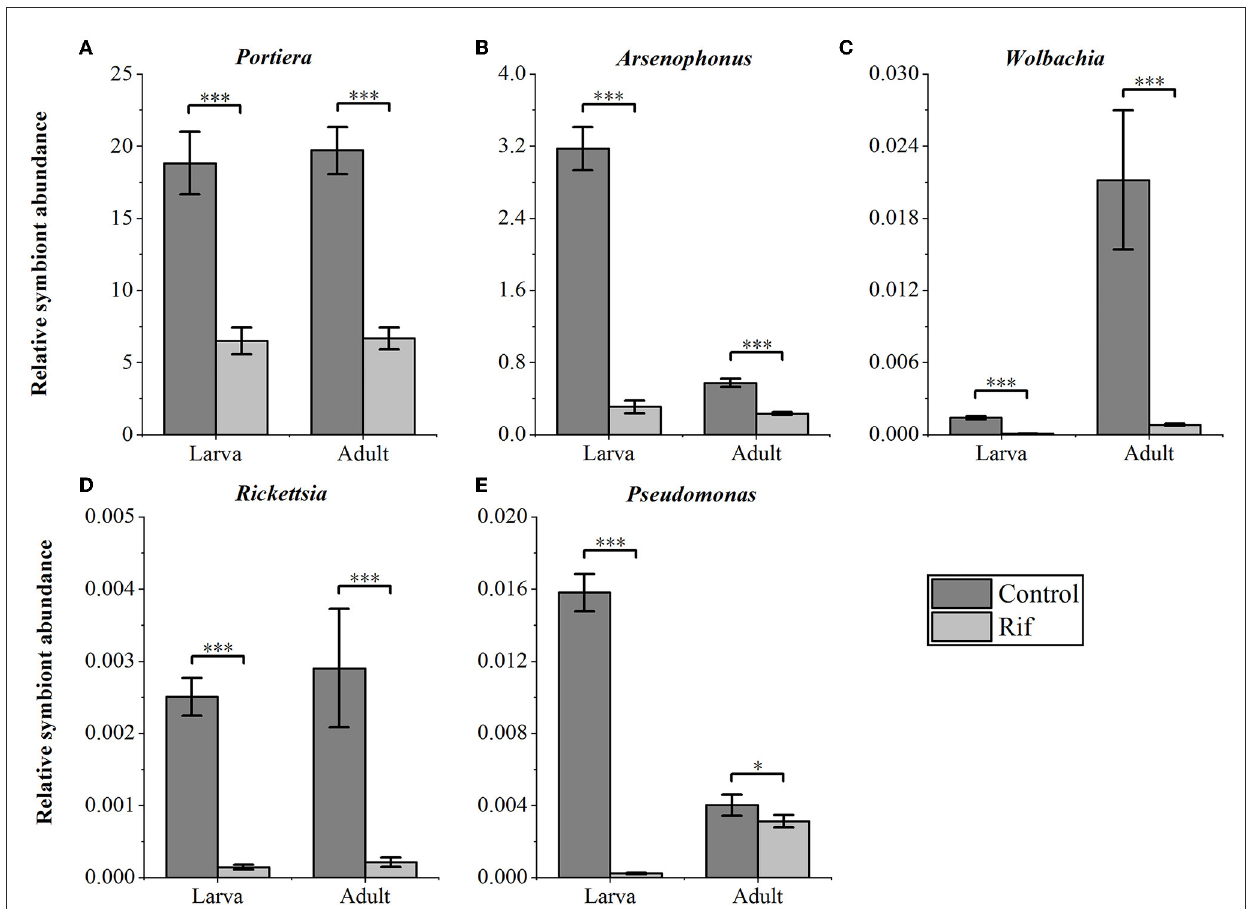
FIGURE4 qPCR quantification of bacterial symbionts in A. camelliae accompanied by rifampicin (Rif) treatments in the larva (3 rd nymph) and adult stages. (A) Portiera , (B) Arsenophonus , (C) Wolbachia , (D) Rickettsia , and (E) Pseudomonas . The error bars indicate the standard errors (* P < 0.05, *** P < 0.001, t -test. N =